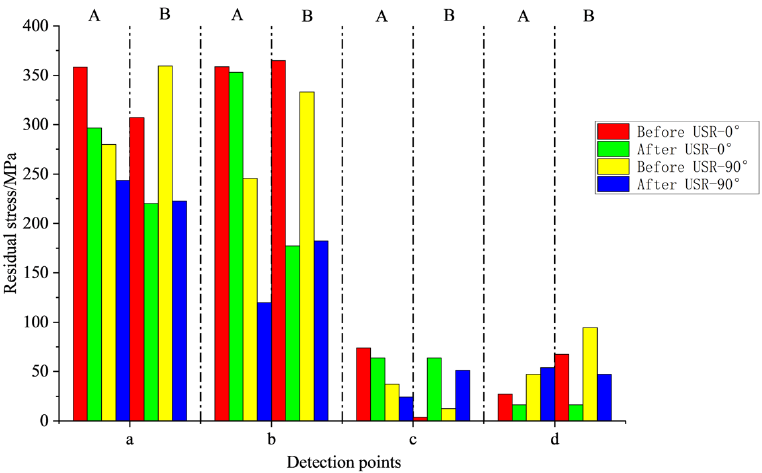
Figure 12. Residual stress changes before and after USR.